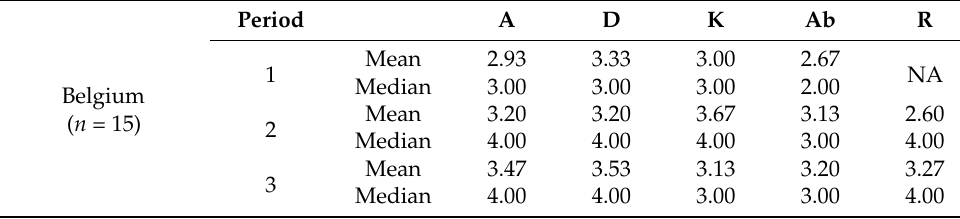
Table 1. Awareness, Desire, Knowledge, Ability, and Reinforcement (ADKAR ® ) scores of the broiler farmers for all coaching periods. Reinforcement (R) was not determined in period